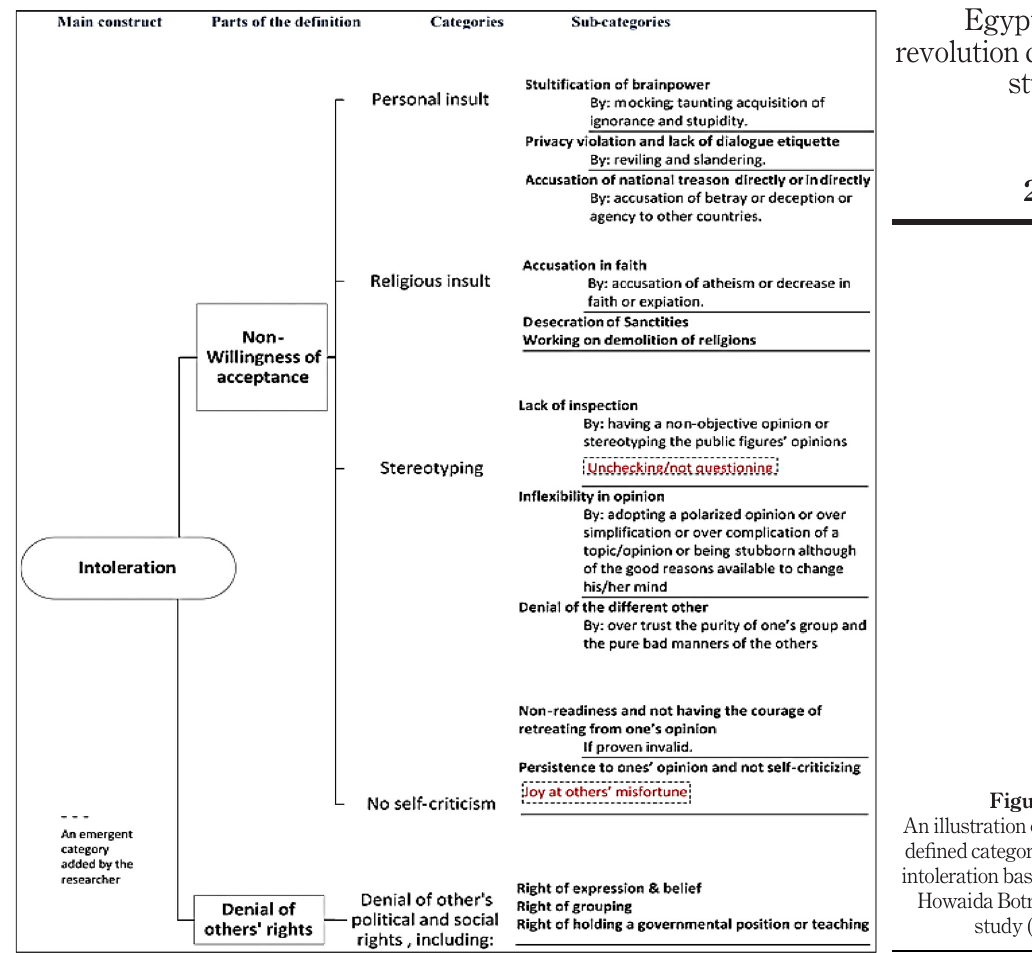
Figure 2. An illustration of